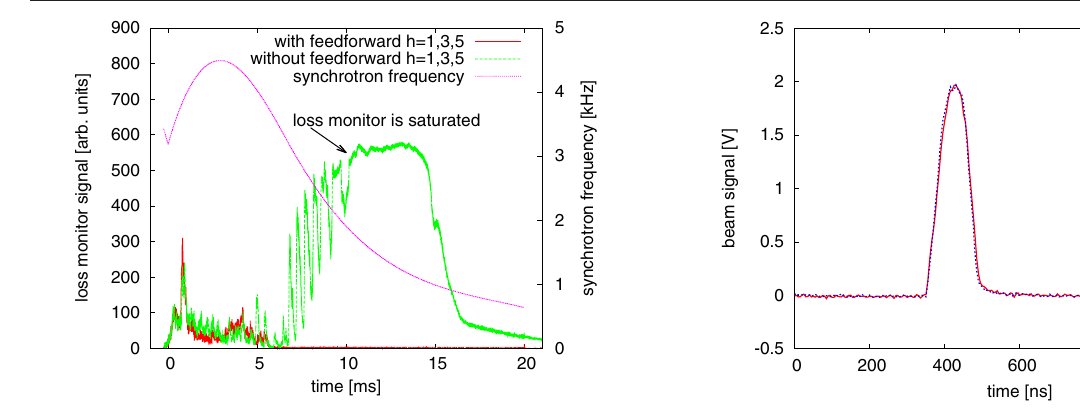
FIG. 8. A comparison of the WCM beam signals just before extraction in cases of acceleration of a single bunch and two bunches of 2 . 3 × 10 13